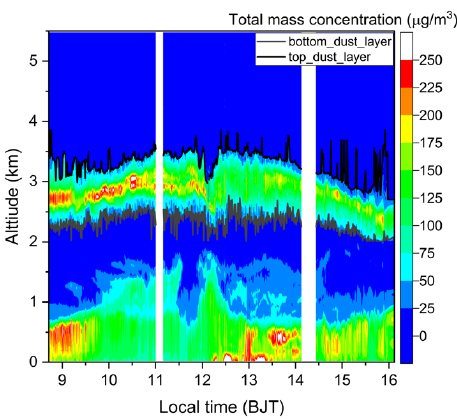
Figure 9. Aerosol total mass concentration profiles derived using the MEE approach on 17 May 2017 along the transect from Tianjin to Tangshan (BJT = Beijing time). The calculations were done considering a dust aerosol model for the layer in the 2–3.5 km range and an urban-industrial aerosol model for the rest of the profile.